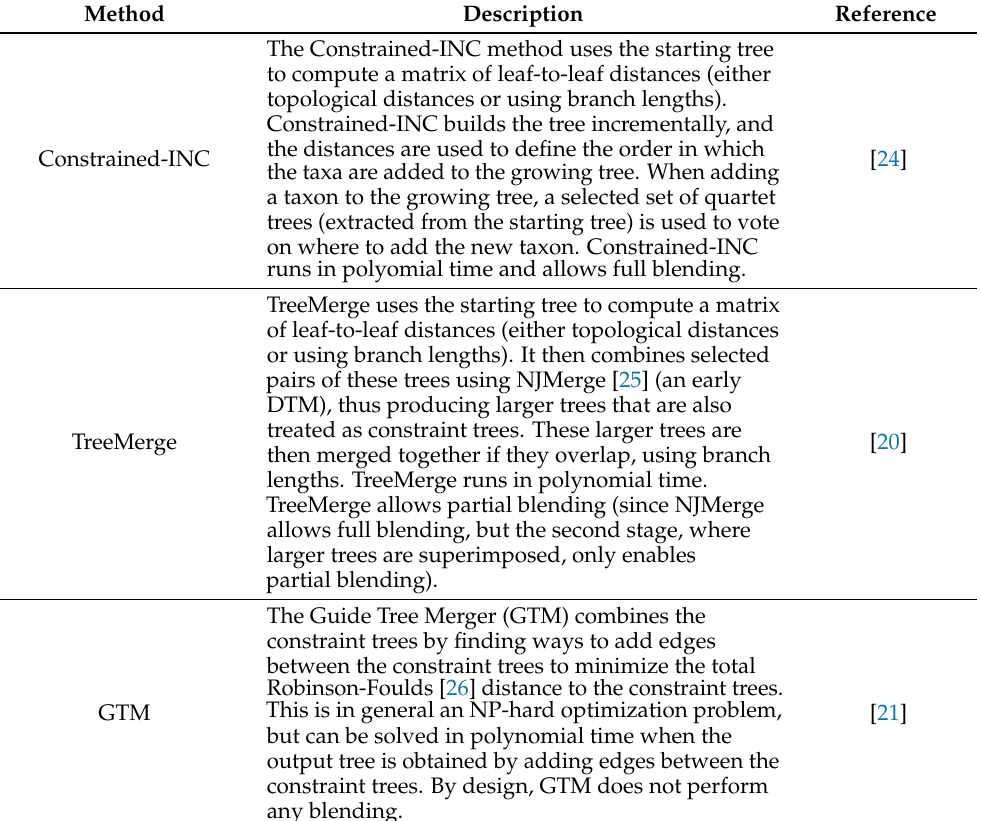
Table 1. Description of DTM methods used in this study. DTMs are used inside divide-and-conquer pipelines, as described in Figure 1, where they are used to combine trees on disjoint subsets (requir- ing that the subset trees are induced in the final tree). Each requires some auxiliary information, described here in terms of a user-provided starting tree that is estimated from the input multiple sequence